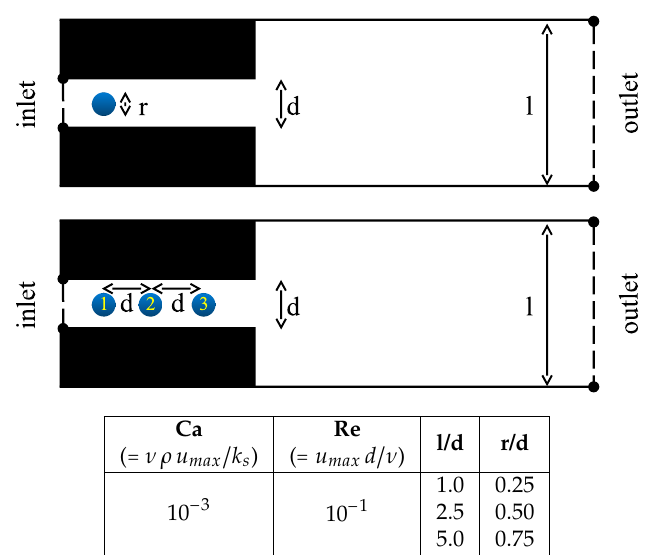
Figure 1. Schematic of the physical problem. ( Top ) sketch of the computational domain with characteristics dimensions and lengths, as well as boundary conditions; ( Bottom ) non-dimensional groups used in the computations: the capillary number regulating the mechanical stiffness of the membranes, Ca ; the Reynolds number regulating the flow velocity, Re ; the ratio between channel diameter and reservoir height, l / d , and the ratio between particle diameter and reservoir height, r / l